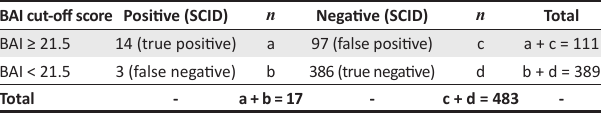
TABLE 4: Two-by-two table of BAI versus structured clinical interview generalised anxiety disorder diagnosis. BAI cut-off score Positive (SCID)